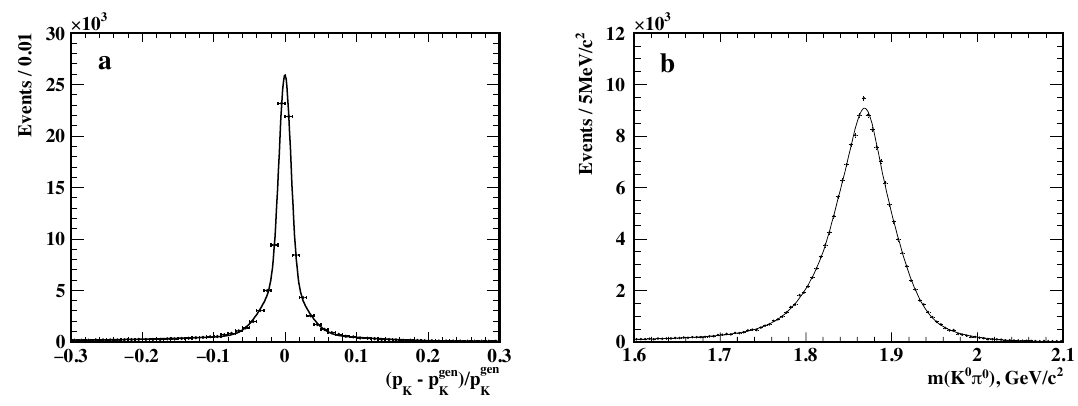
Figure 3 . (a) Relative K 0 momentum resolution, (b) distribution of the K 0 (cid:25) 0 invariant mass for selected